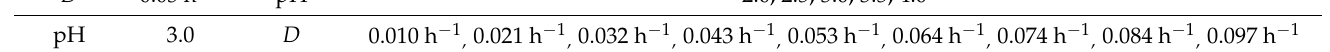
Table 1. Experimental plan of this study: chemostat cultivations with a dilution rate ( D ) of 0.03 h − 1 were performed at 5 different pH values. The following set of experiments where the dilution rate was varied from 0.010 h − 1 to 0.097 h − 1 was then performed at the prior determined pH optimum of 3.0. Fixed